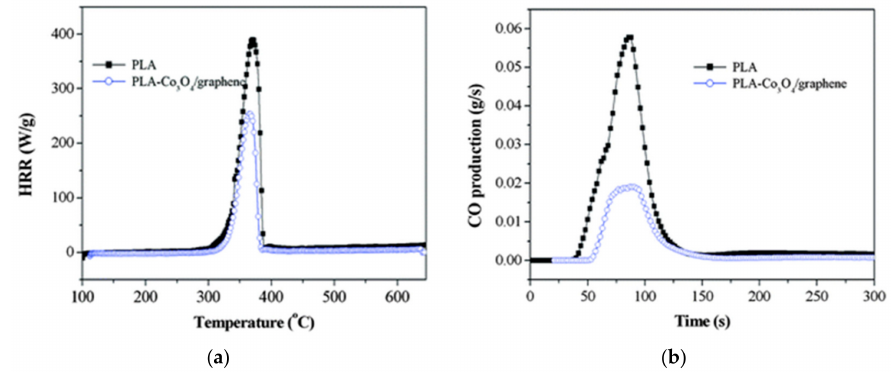
Figure 4. ( a ) Heat release rate and ( b ) CO curve of the PLA/CO 3 O 4 /graphene composite (Adapted with permission from